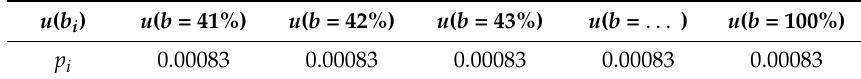
Table 5. The probability values of network disruptions in the operation of the S 1 network corresponding to the b discount on the second level.